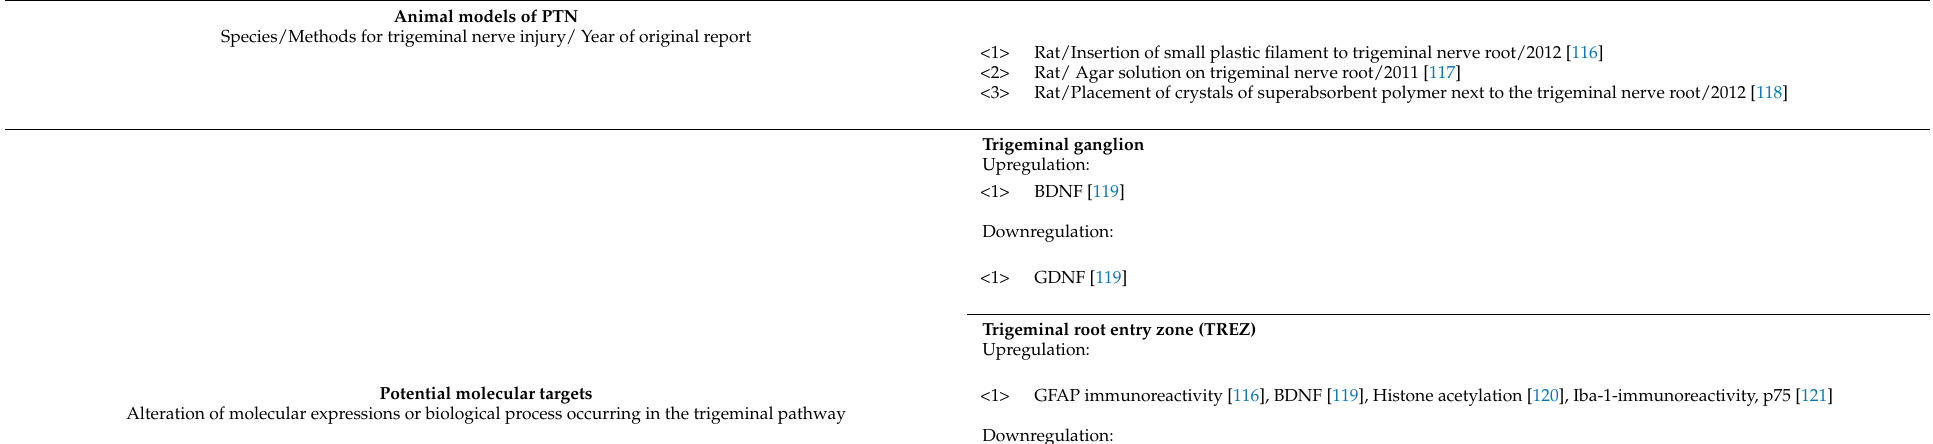
Table 2. Current findings in animal models of primary trigeminal neuralgia